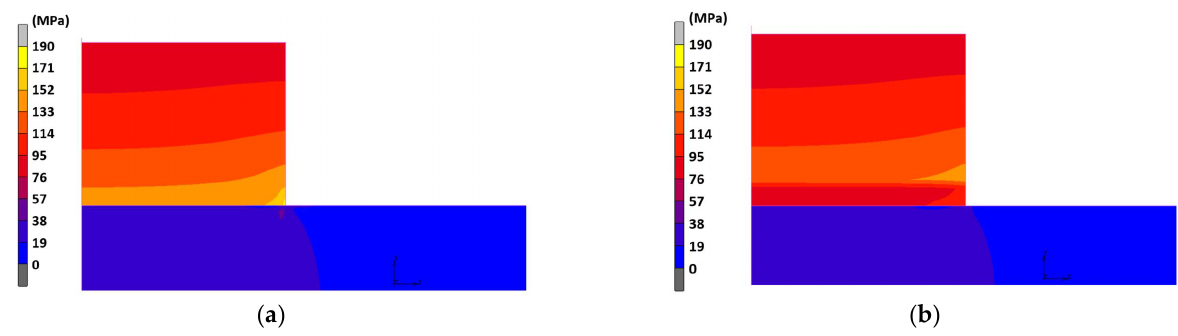
Figure 7. Distributions of the von Mises stress in: ( a ) a conventional shrink fit (without a contact ring), and ( b ) a modified shrink fit with a contact ring ( γ = 0.050).